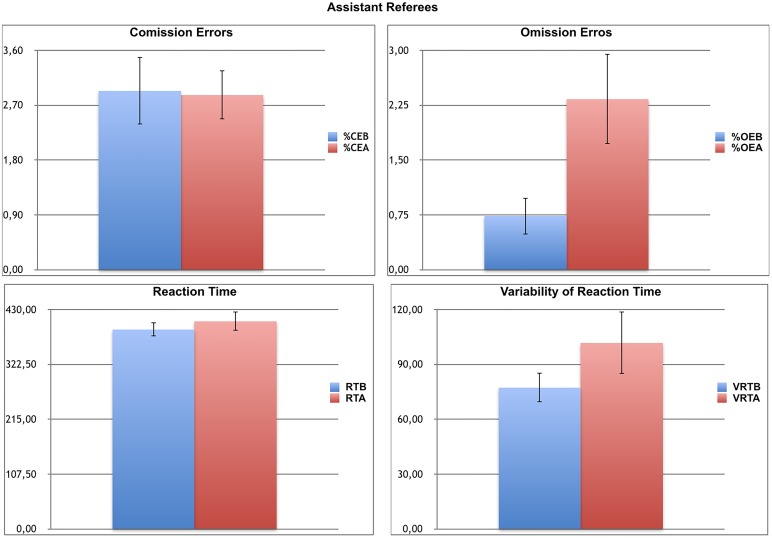
Attentional Performance of Referee Assistants before and after the physical fitness test. Note the significant increase in VRT and %OE in the second attention test. %CE, percentage of commission errors; %CEB, percentage of commission errors before the FIFA-Test; %CEA, percentage of commission errors after the FIFA-Test; %OE, percentage of omission errors; %OEB, percentage of omission errors before the FIFA-Test; %OEA, percentage of omission errors after the FIFA-Test; RT, reaction time; RTB, reaction time before the FIFA-Test; RTA, reaction time after the FIFA-Test; VRT, variability of reaction time; VRTB, variability of reaction time before FIFA-Test; VRTA, variability of reaction time after the FIFA-Test; CVAT, Computer Visual Attention Test. Data are expressed as means and each bar is the respective standard error of the mean.